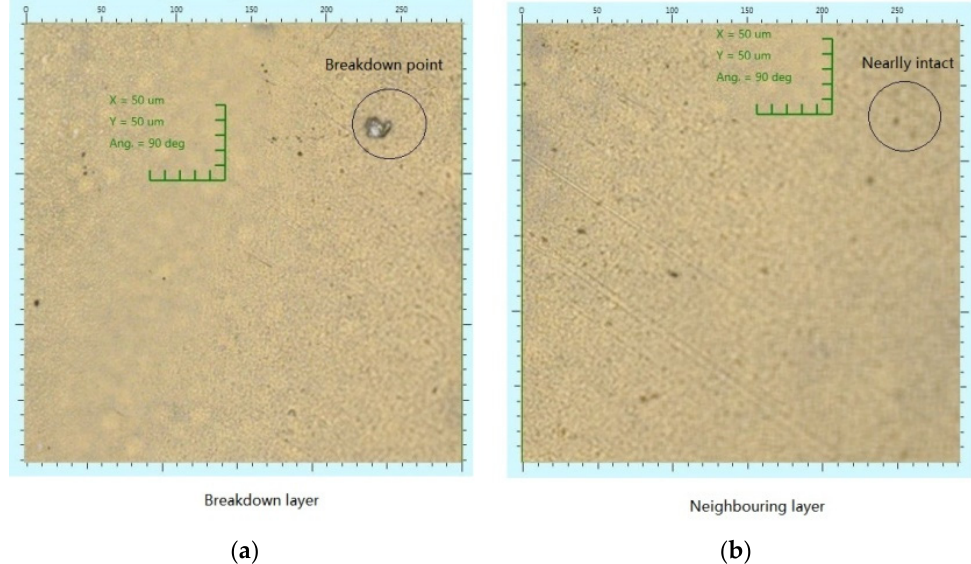
Figure 8. Microscopic images of the breakdown layer ( a ) and the neighboring layer ( b ) in a multi- layer film.